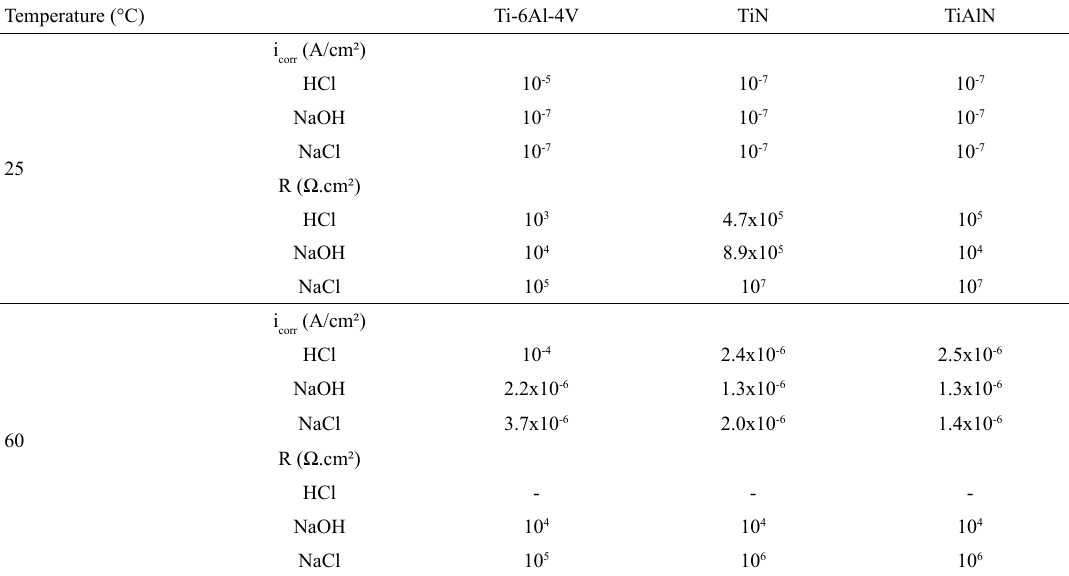
Table 5. Main results obtained from Ti-6Al-4V corrosion tests in HCl 9 and NaCl 10 . Temperature (°C)